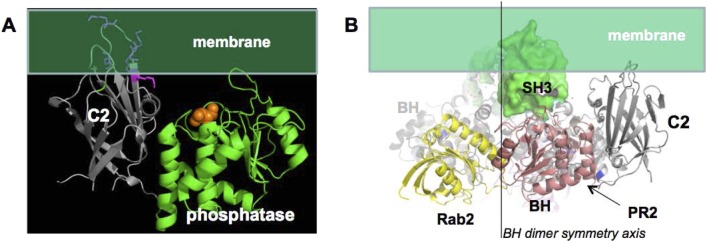
(A) approximate positioning of PTEN with respect to the membrane (green).C2 residues required for membrane binding are highlighted. Orange spheres represent a bound L(+)-tartrate molecules found in the PTEN crystal structure (1D5R) and are thought to mimic interactions of PTEN with substrate phosphates(Lee et al., 1999). (B) When oriented with the SH3 domains (green) pointing towards the membrane, the two PTEN molecules cannot simultaneously interact with the membrane and with PR2.